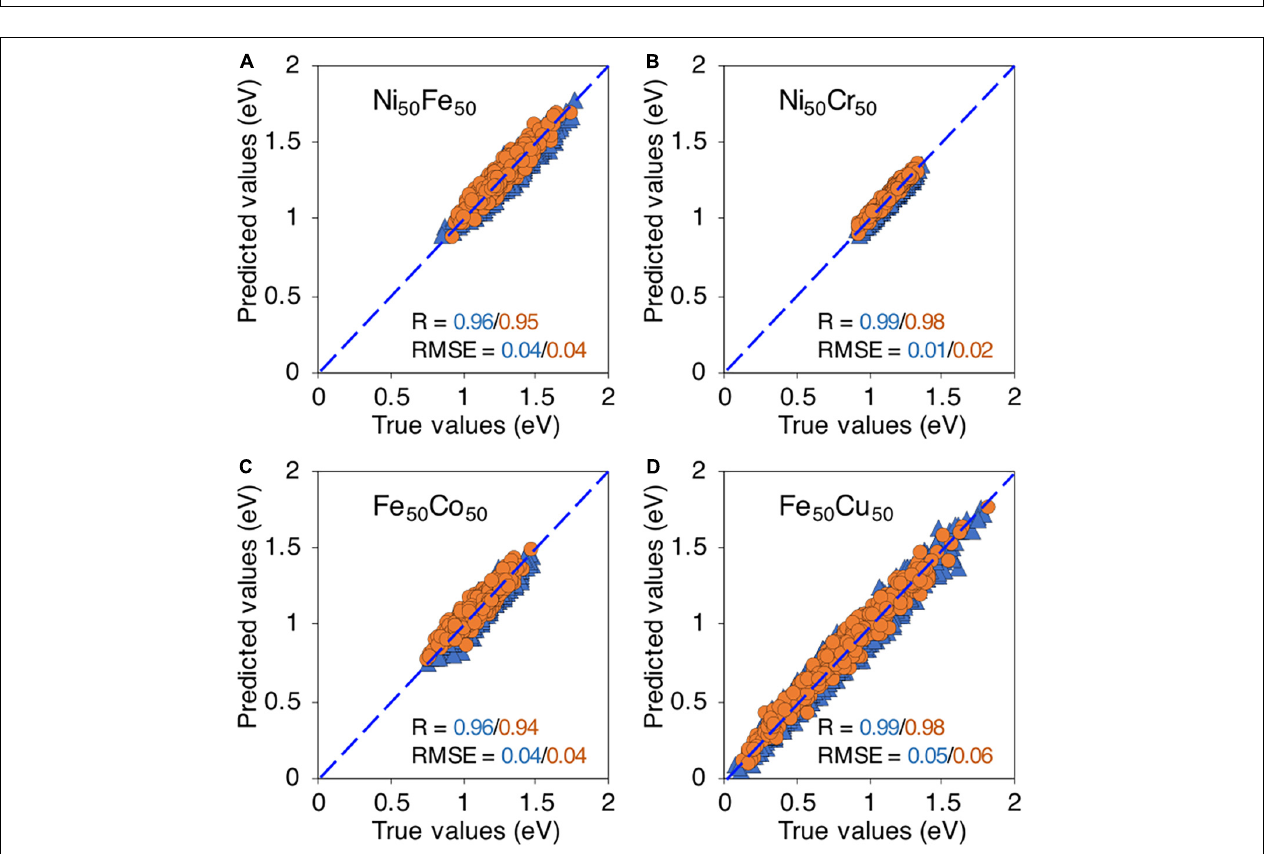
FIGURE 6 | True vs machine learning predicted vacancy migration energies in, (A) Ni 50 Fe 50 , (B) Ni 50 Cr 50 , (C) Fe 50 Co 50 , and (D) Fe 50 Cu 50 . The blue triangles and orange circles are training and testing data points respectively.